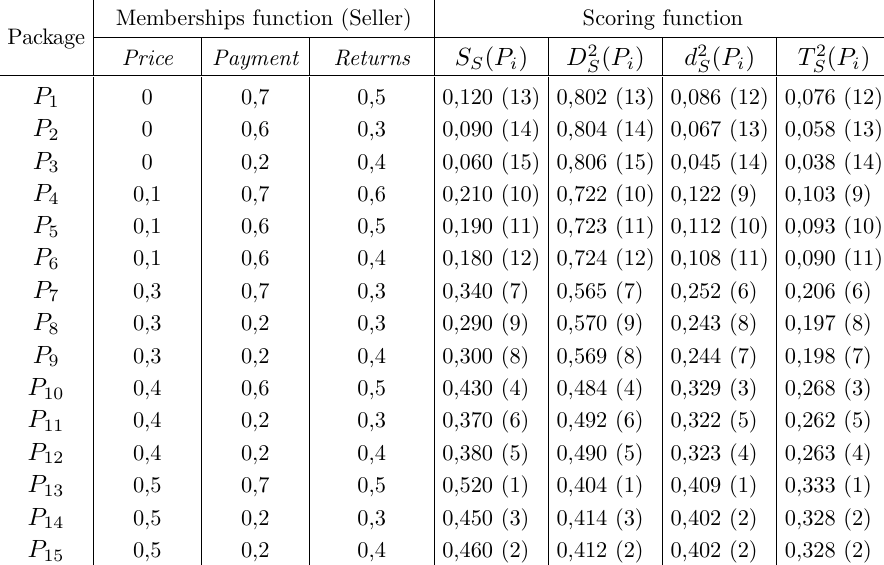
Seller’s scoring